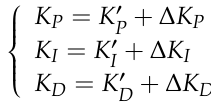
Figure 4. fuzzy controller structure. The fuzzy controller can be divided into single variable fuzzy controller and multi-variable fuzzy controller. We usually use univariate fuzzy controller, which has one-dimensional, two- dimensional and multidimensional fuzzy controller. The dimension here refers to the number of input variables for the controller, as shown in Figure 5. Fuzzy controller ue